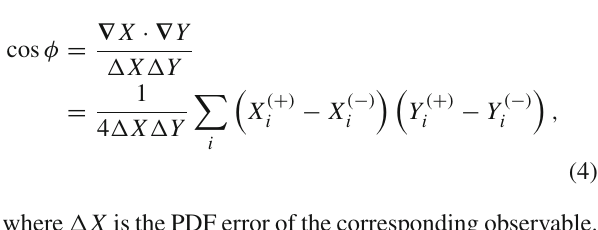
Fig. 10 W charge asymmetry for PbPb collisions at the LHC with Corresponding predictions obtained with nCTEQ15 and CT10 PDFs are also